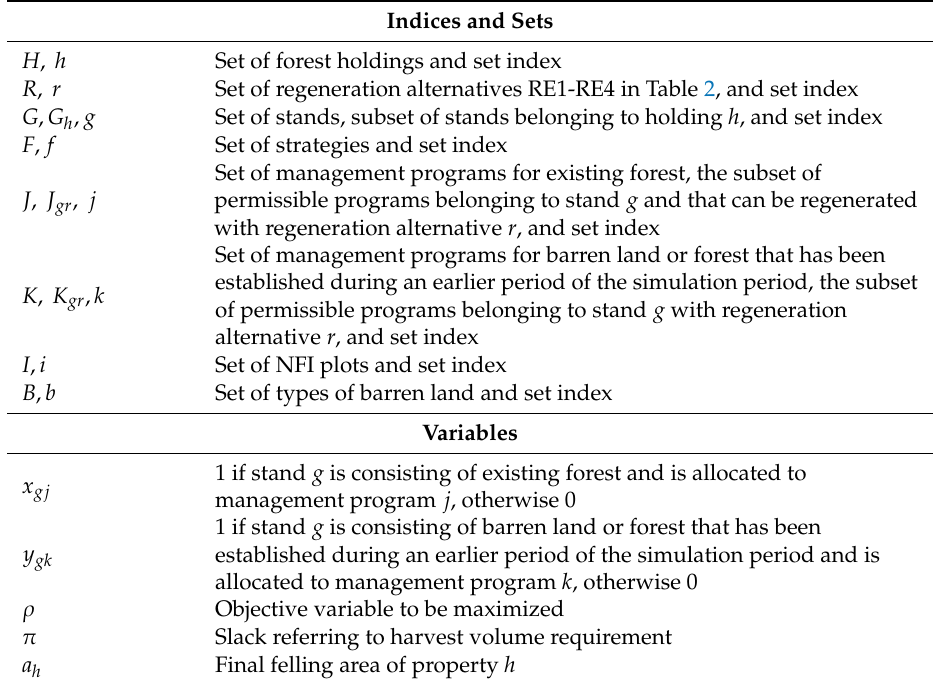
Table A1. Optimization model